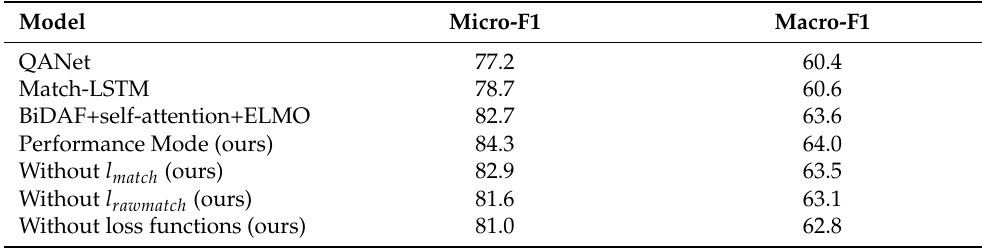
Table 6. Ablation experiments based on contrastive learning.